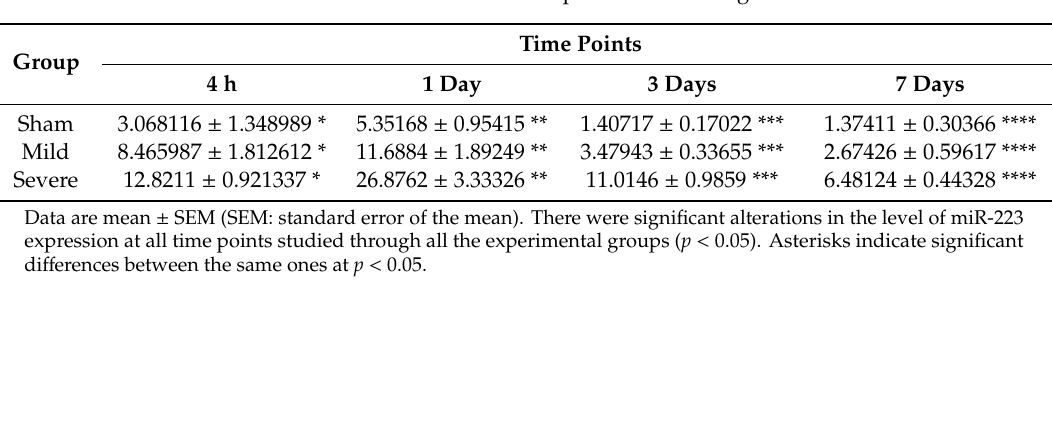
Table 3. Alterations in the level of miR-223 expression according to the time course.